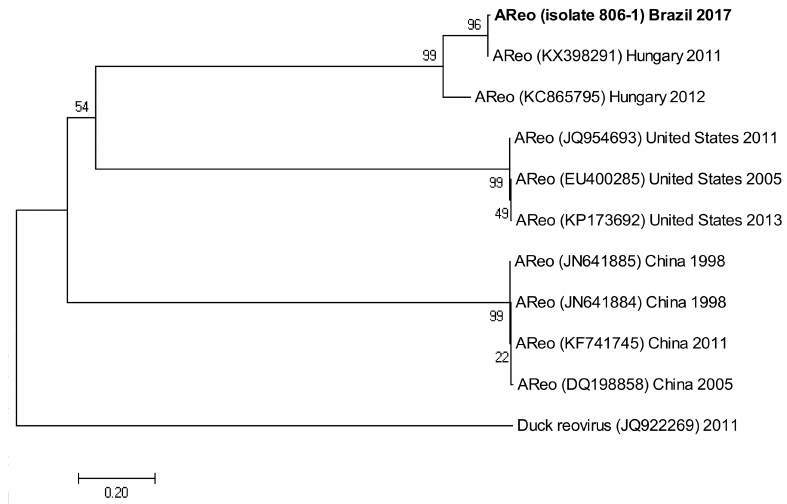
Figure 4. Phylogenetic tree for AReo strains, was inferred with the neighbor-joining statistical method and based on the partial sequence of segment S4. Numbers along the branches refer to bootstrap values for 1000 replicates. Sequence of Duck Reovirus was used as out-group